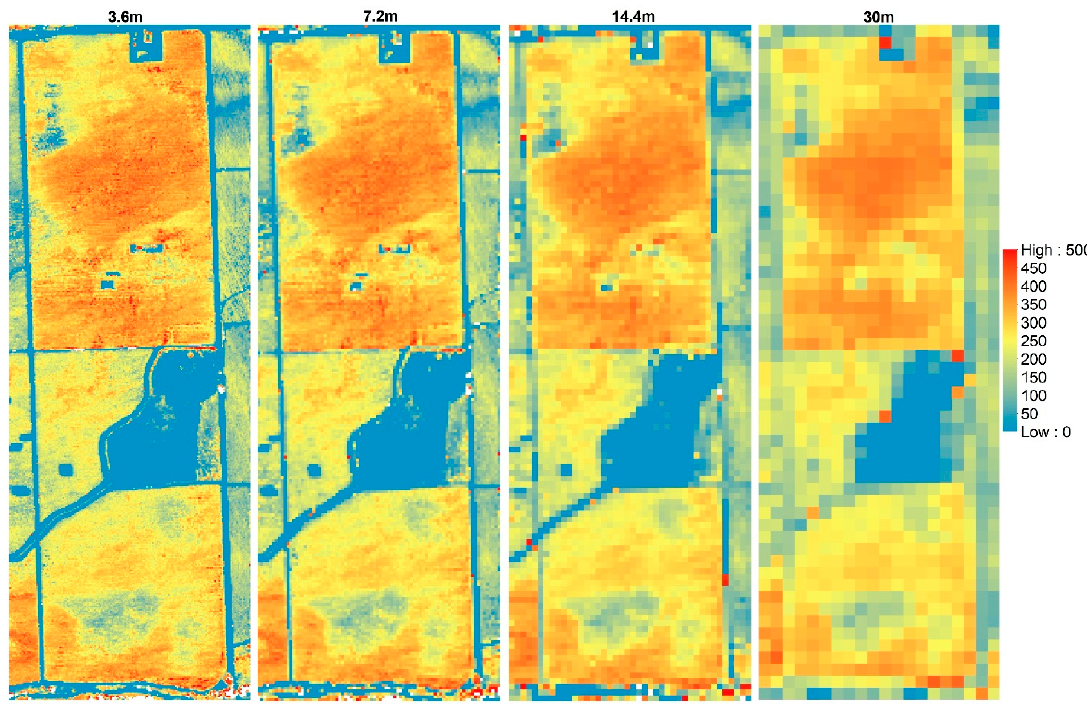
Figure 11. LE (w/m 2 ) aggregation at 3.6 m, 7.2 m, 14.4 m and 30 m for 09 August 2014.